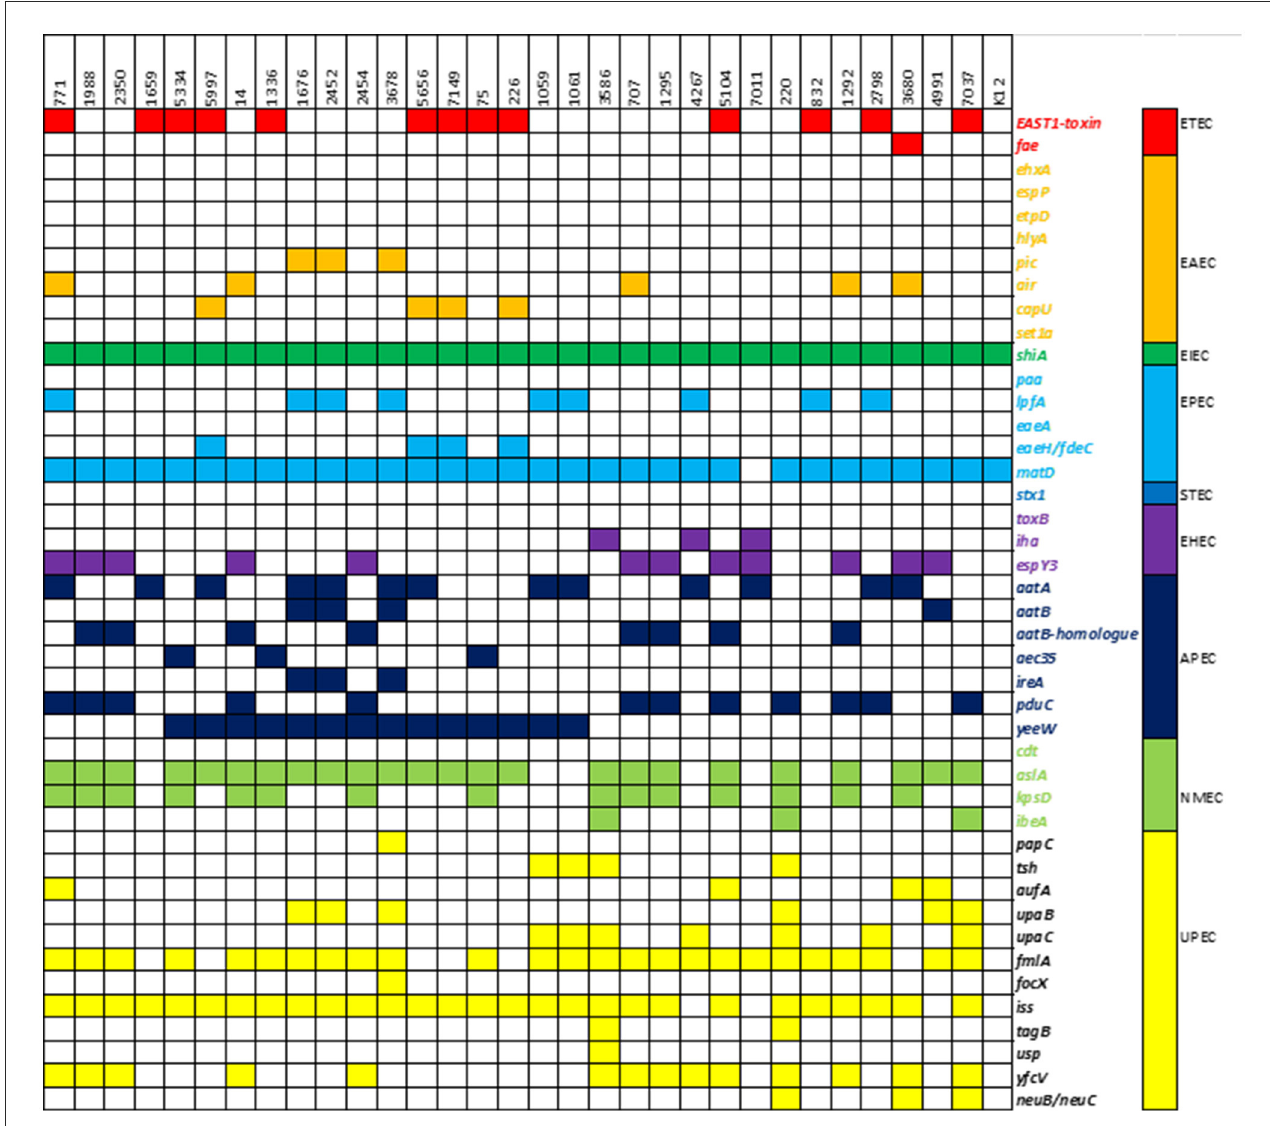
FIGURE4 Heatmap of virulence-associated genes: presence of a selection of 41 virulence-associated genes and their respective pathogroups in the study